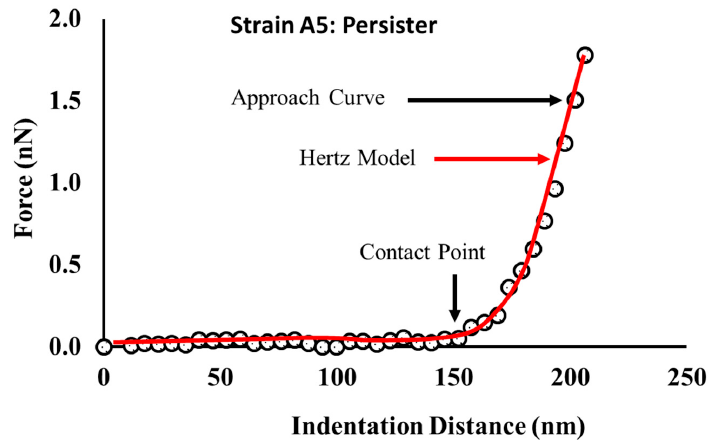
Figure 11. A representative indentation-force profile obtained on one of the A5 persister cells. The location of the contact point (CP) was obtained manually from the AFM Nanoscope Analysis 1.5 software (Bruker, Camarillo, CA, USA) and indicated by the downward black arrow. The force–indentation data were obtained from a persister cell exposed to a 1000 µg/mL of ampicillin for 25 h.